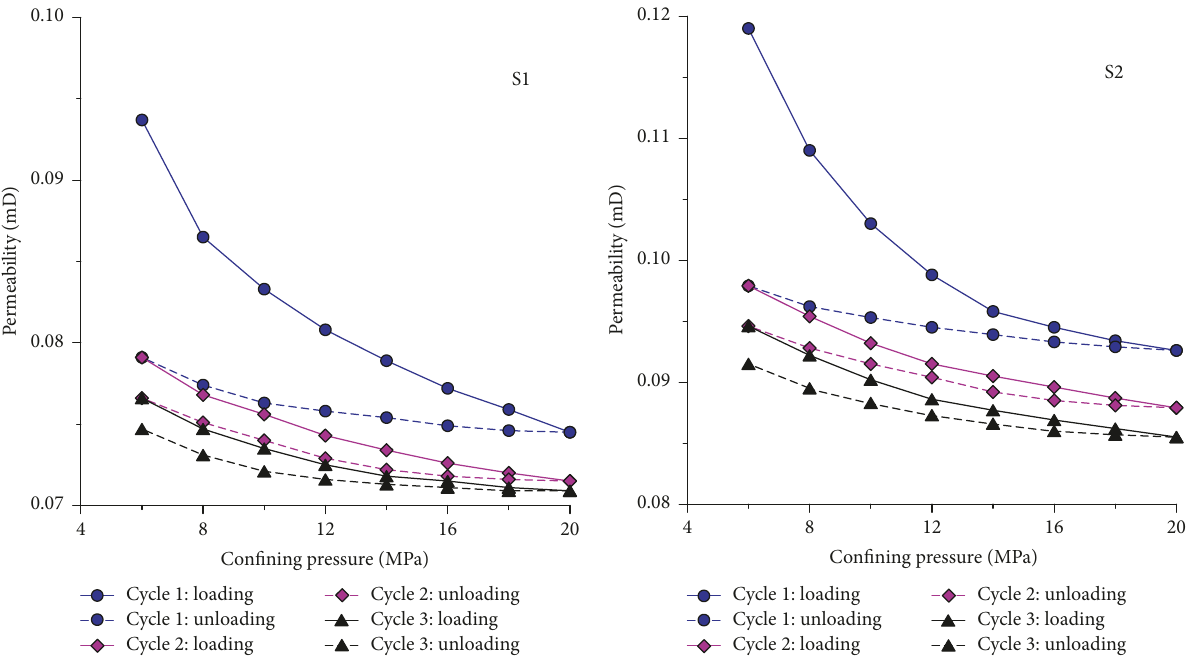
Figure 7: Relationship between permeability and confining pressure under constant injection pressure.